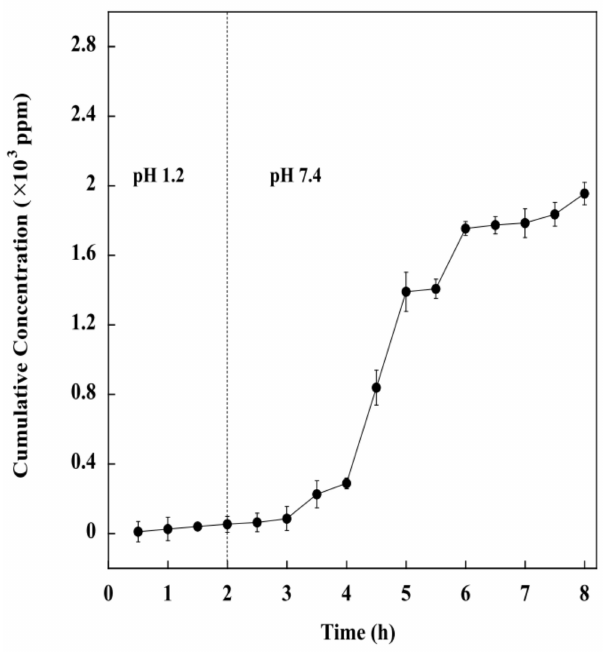
Figure 10. Release of drug from hydrogel at pH 1.2 and 7.4. Table 3. The fitting data of model drug release obtained with different mathematical